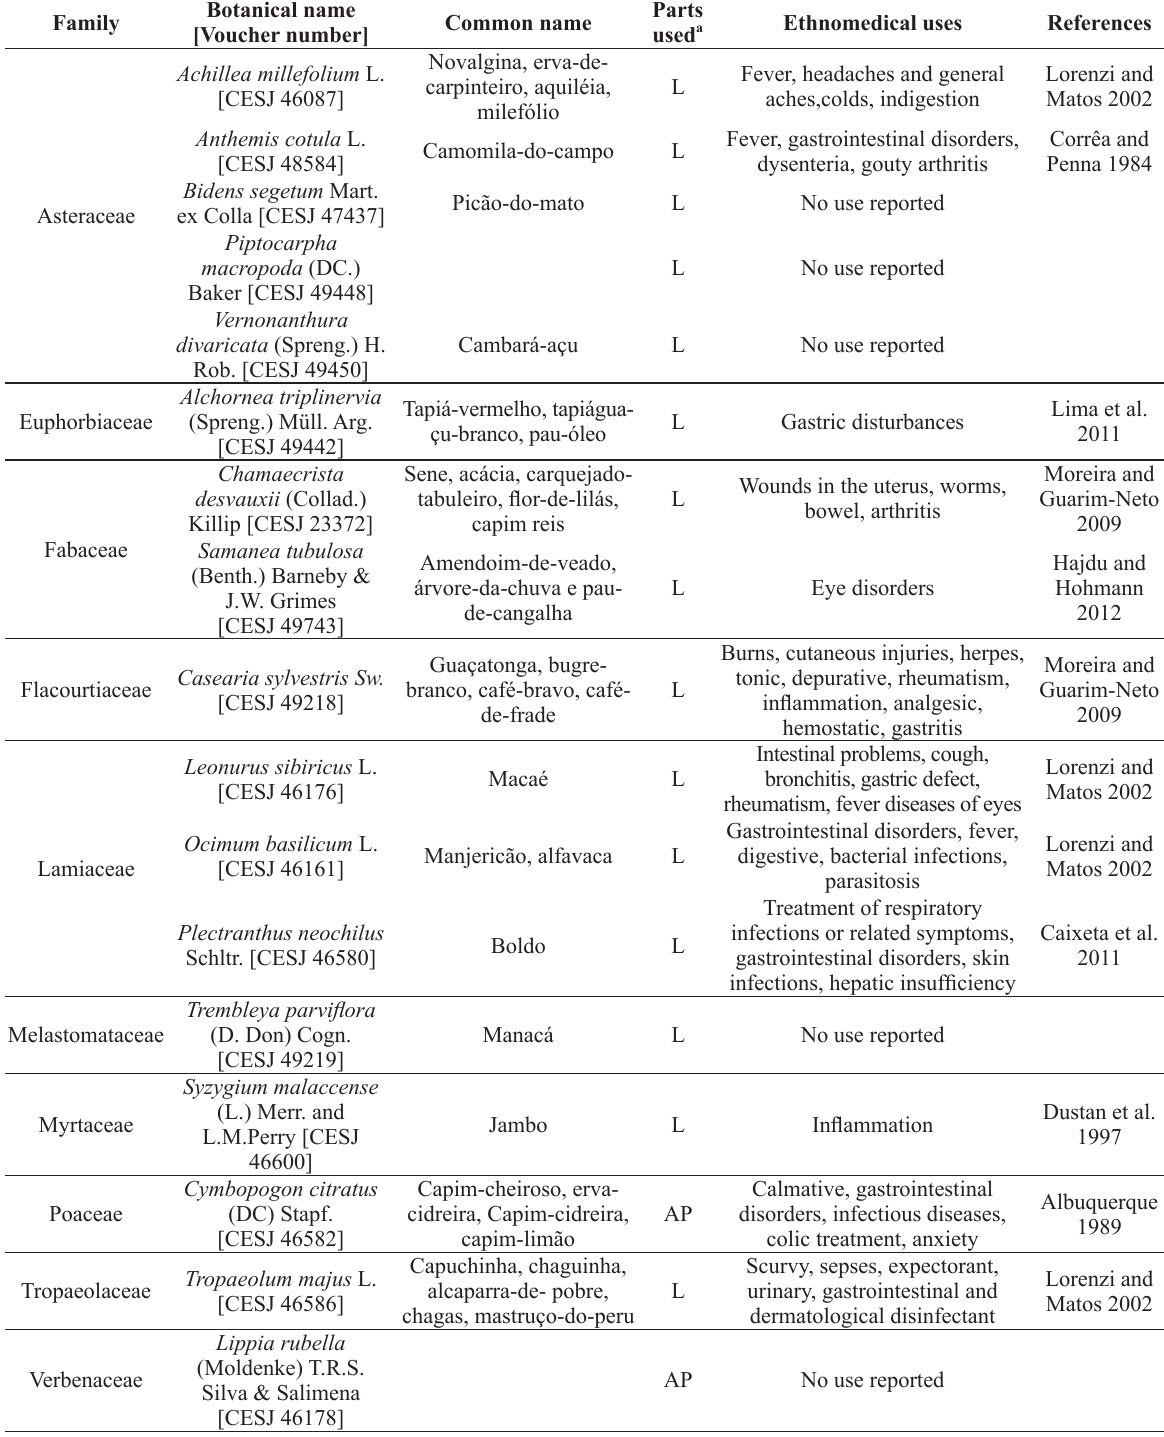
Ethnomedical data on medicinal